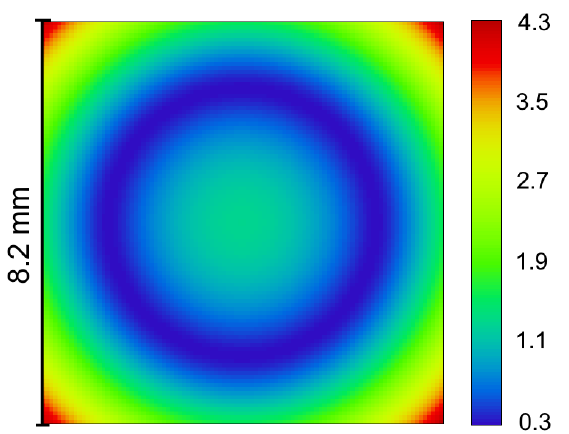
Figure 2. RMS spot radius distribution across the linear field of view (in